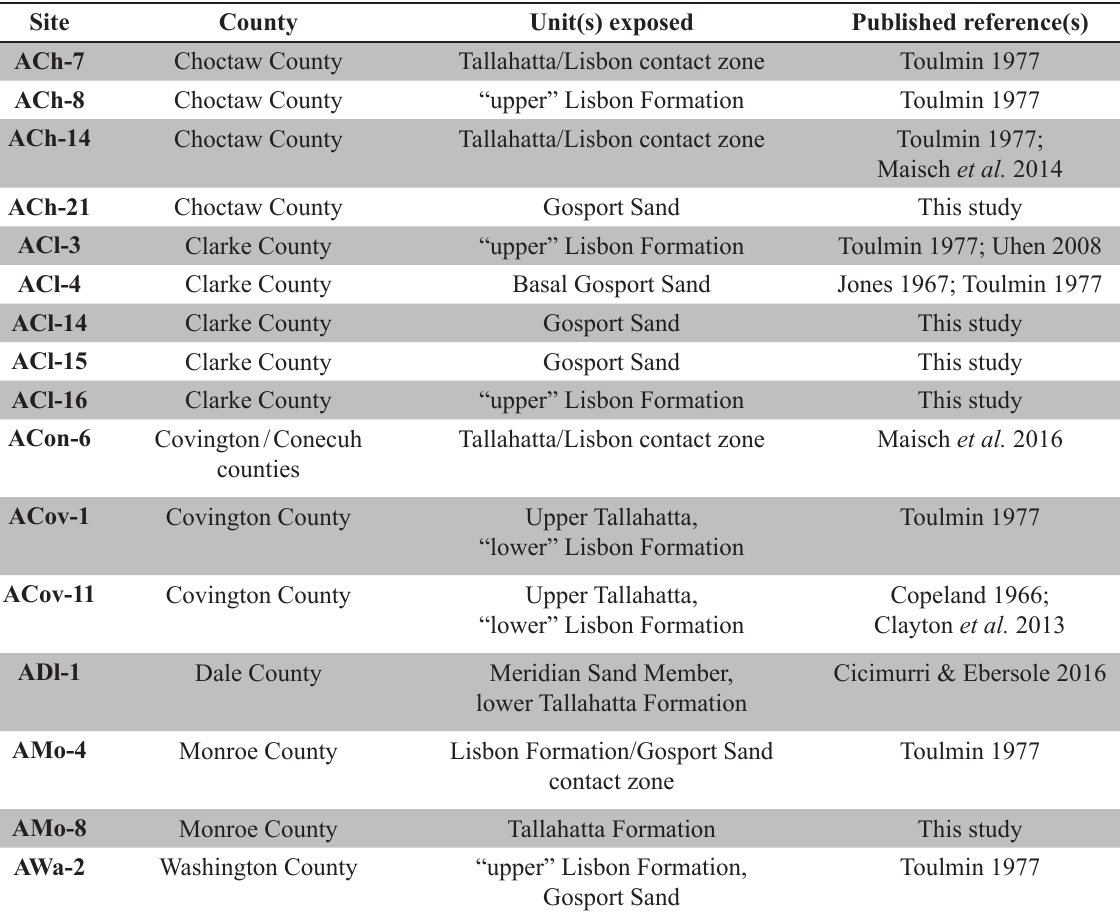
Table 1. Claiborne Group localities that produced remains examined in